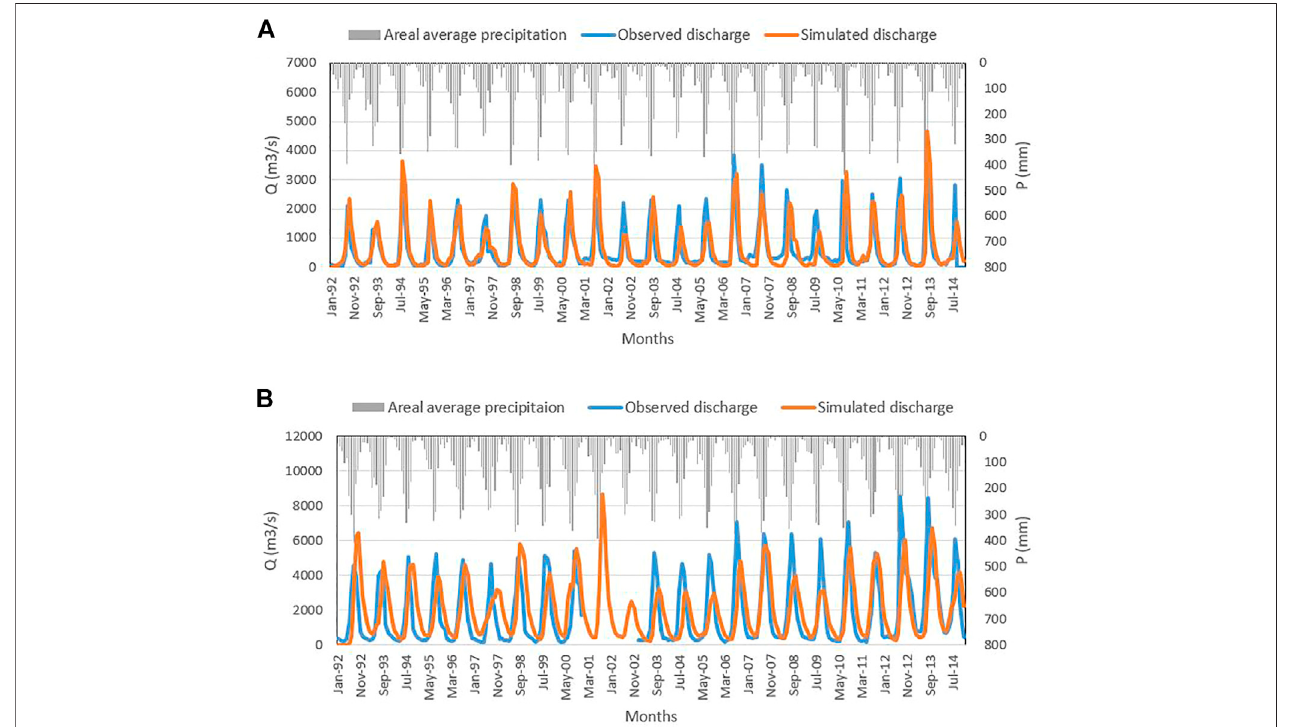
FIGURE 5 | Comparison of WEP simulated monthly discharges at two locations: Kessie station (A) and El-Diem station (B) .